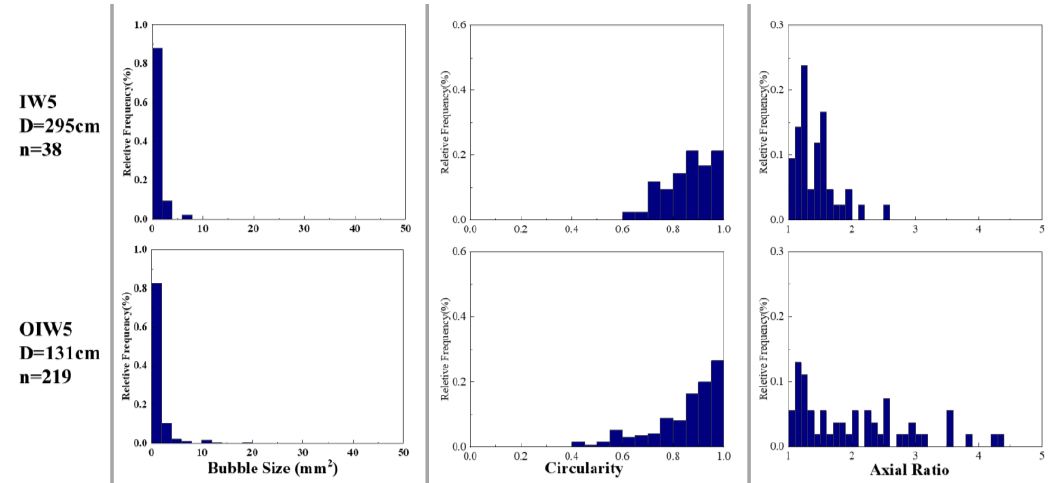
Figure 5. Bubble frequency distribution diagrams. ‘D’ means depth, ‘n’ means number of bubbles. ( a ) Frequency distributions of bubble size (mm 2 ); ( b ) frequency distributions of bubble circularity; ( c ) frequency distributions of bubble axial ratio.